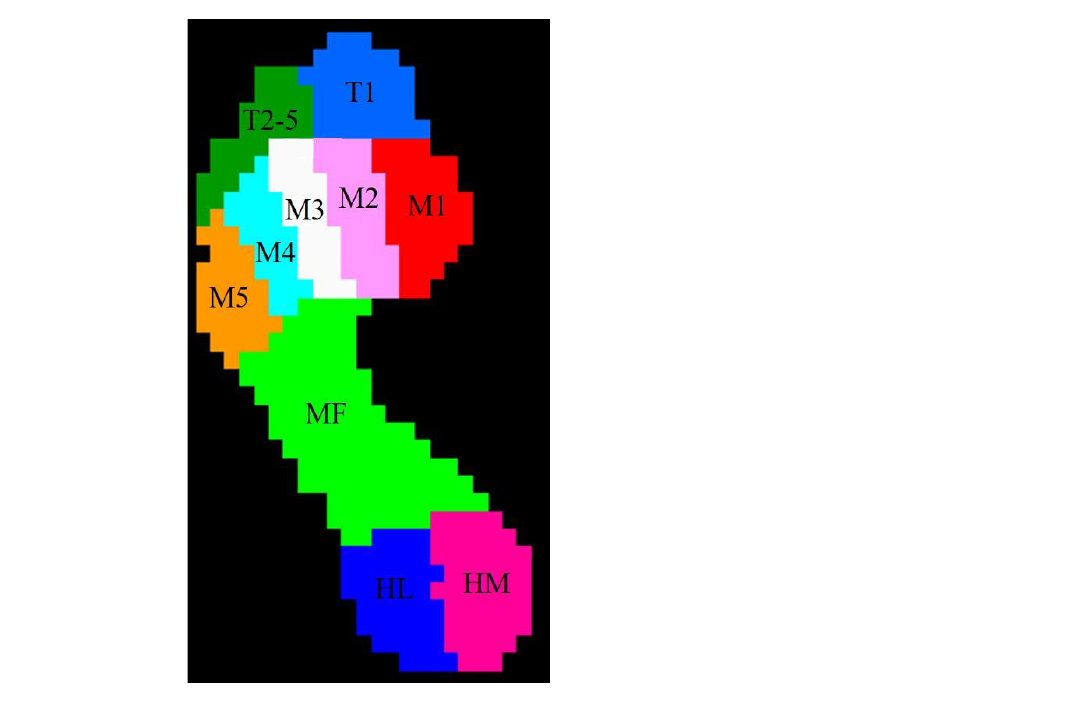
Figure 1. The plantar pressure system divides the foot into 10 regions: ( Ⅰ ) toe 1 (T1), ( Ⅱ ) toes 2 to 5 (T2-5), ( Ⅲ ) metatarsal 1 (M1), ( Ⅳ ) metatarsal 2 (M2), ( Ⅴ ) metatarsal 3 (M3), ( Ⅵ ) metatarsal 4 (M4), ( Ⅶ ) metatarsal 5 (M5), ( Ⅷ ) midfoot (MF), ( Ⅸ ) heel medial (HM), and ( Ⅹ ) heel lateral (HL). Data on gait spatiotemporal parameters (walking speed, stride time, stance time,